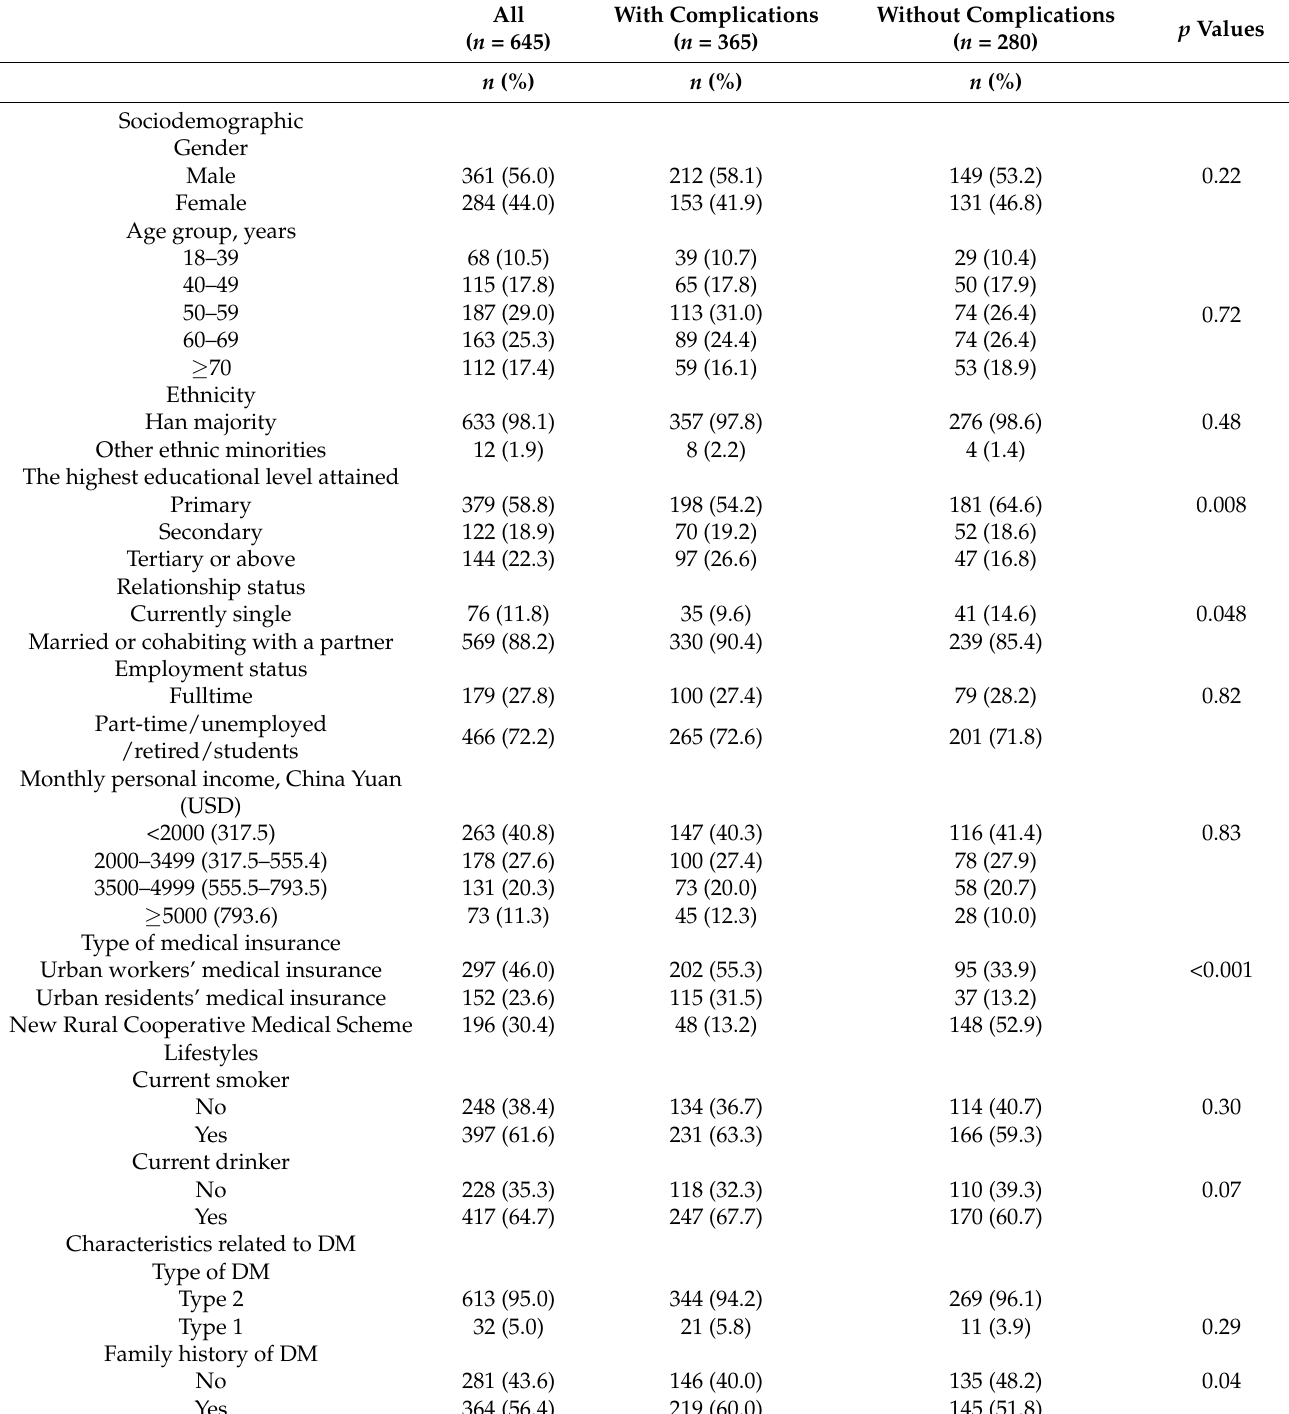
Table 1. Comparing background characteristics between diabetes mellitus (DM) patients with and without